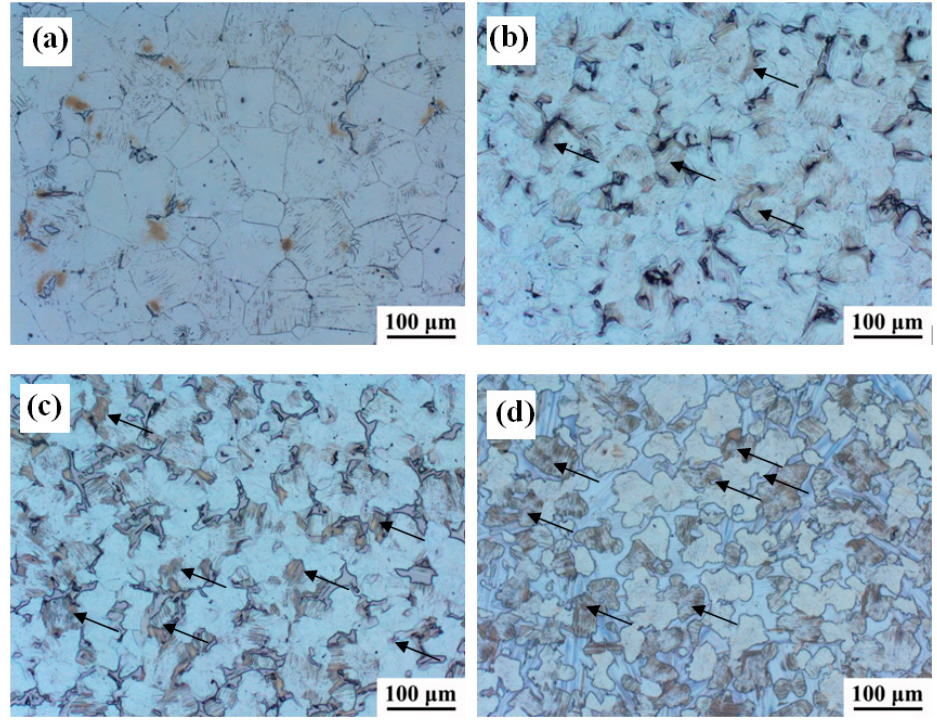
Figure 1. OM images of the experimental alloys: ( a ) 0Zn, ( b ) 0.7Zn, ( c ) 1.5Zn, and ( d ) 3.3Zn.